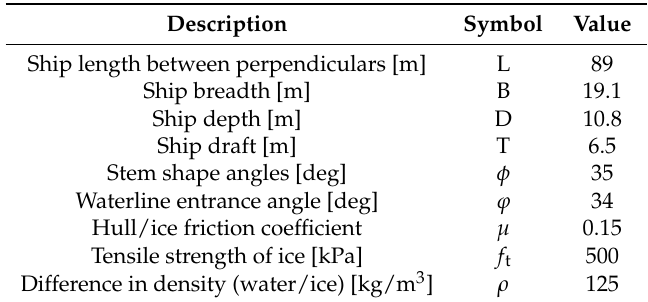
Table 1. Data on KV Svalbard and sea